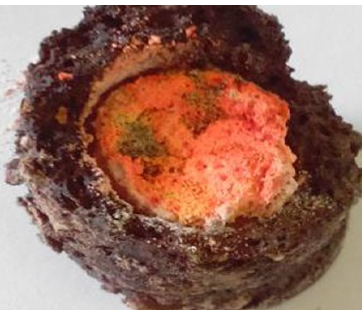
Figure 2. A photograph of the as-synthesized product obtained under the optimum synthesis condition. The outer layer (black in color) is the combustion product of the igniting agent and the inside portion (red in color) is the synthesized phosphor.